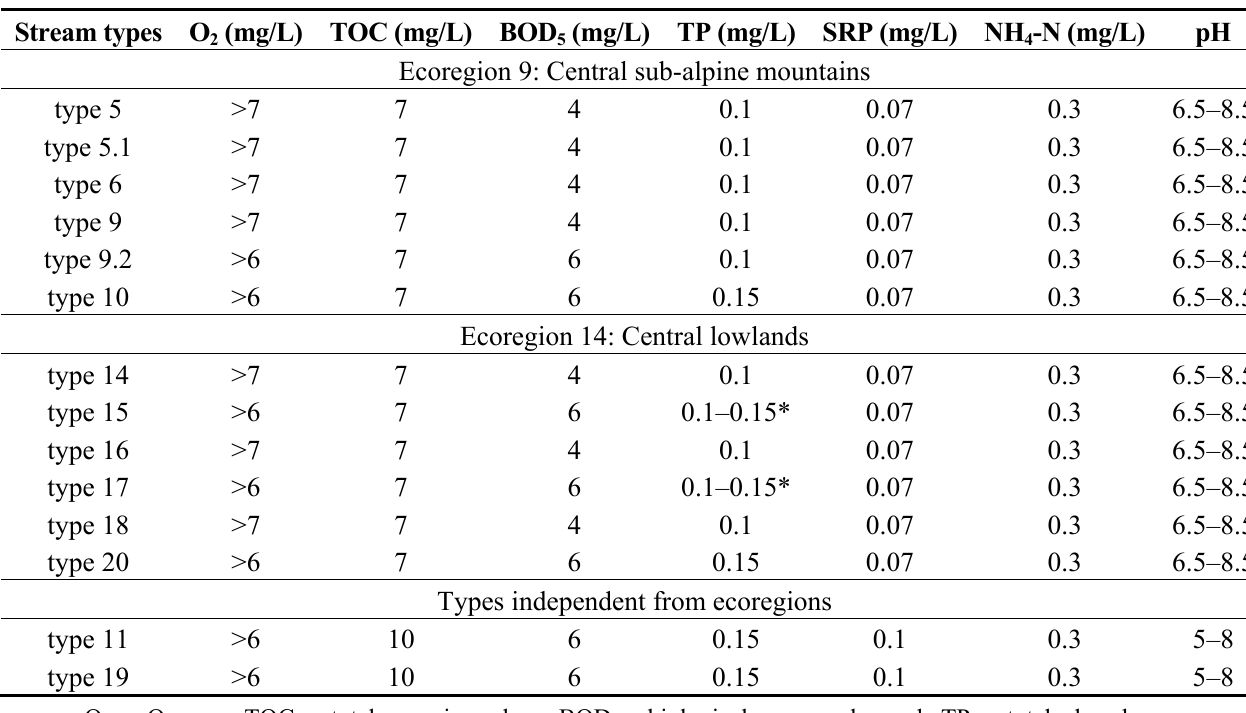
Table 3. Orientation values of physicochemical quality elements according to the